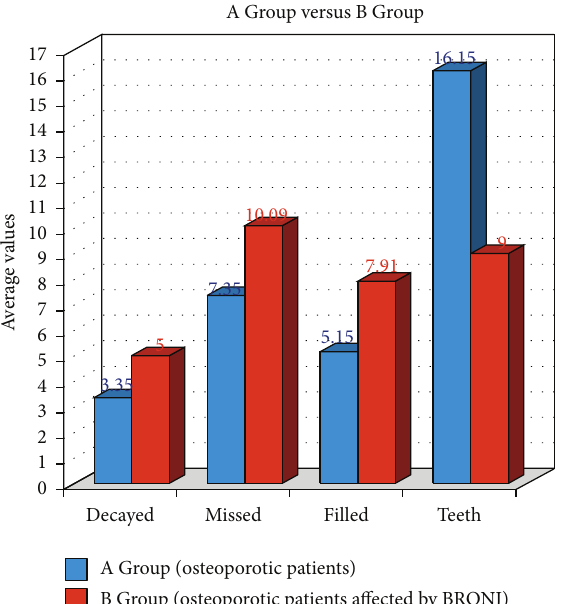
Figure 4: Average number of decayed, missed, and filled teeth recorded for patients in each